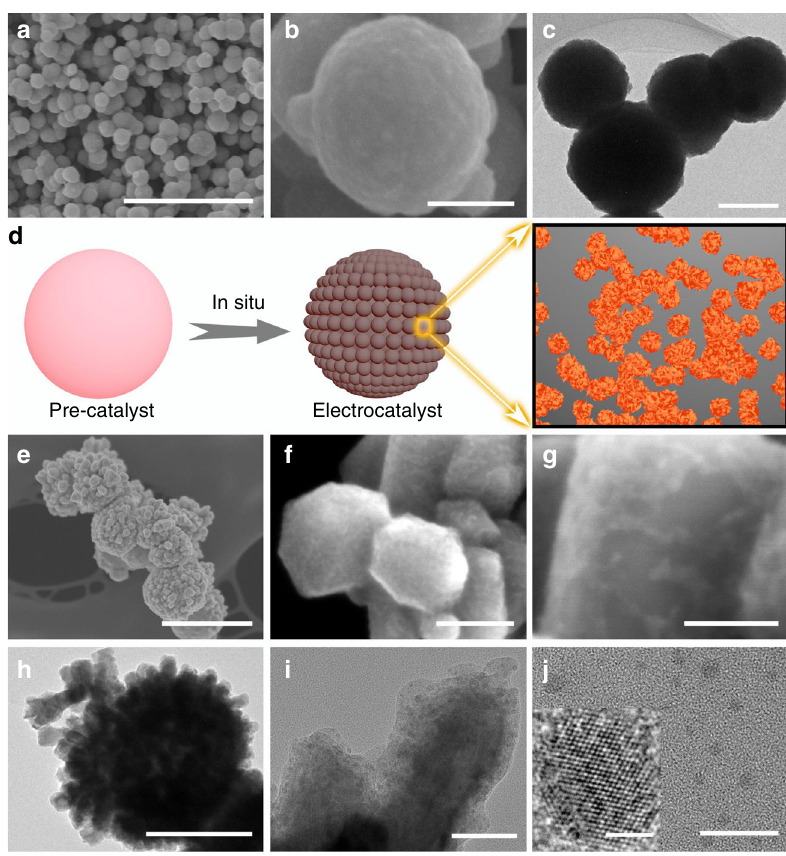
Fig. 2 Structural characterization of pre-catalysts and Cu adparticles. a – c SEM/TEM images of oxide pre-catalysts. The scale bars are 2 μ m in a , 200 nm in both b and c . d Schematic illustration of Cu adparticle growth from in-situ CO-RR. e – g SEM/HRSEM and h – j TEM/HRTEM images of Cu adparticle electrocatalysts obtained under CO-RR at − 0.44 V vs. RHE in 1 M KOH. The scale bars are 500 nm in e , 200 nm in h , 50 nm in both f and i , 20 nm in both g and j , 2 nm in the inset of coordination numbers 38 , as exempli fi ed in the simpli fi ed, small-